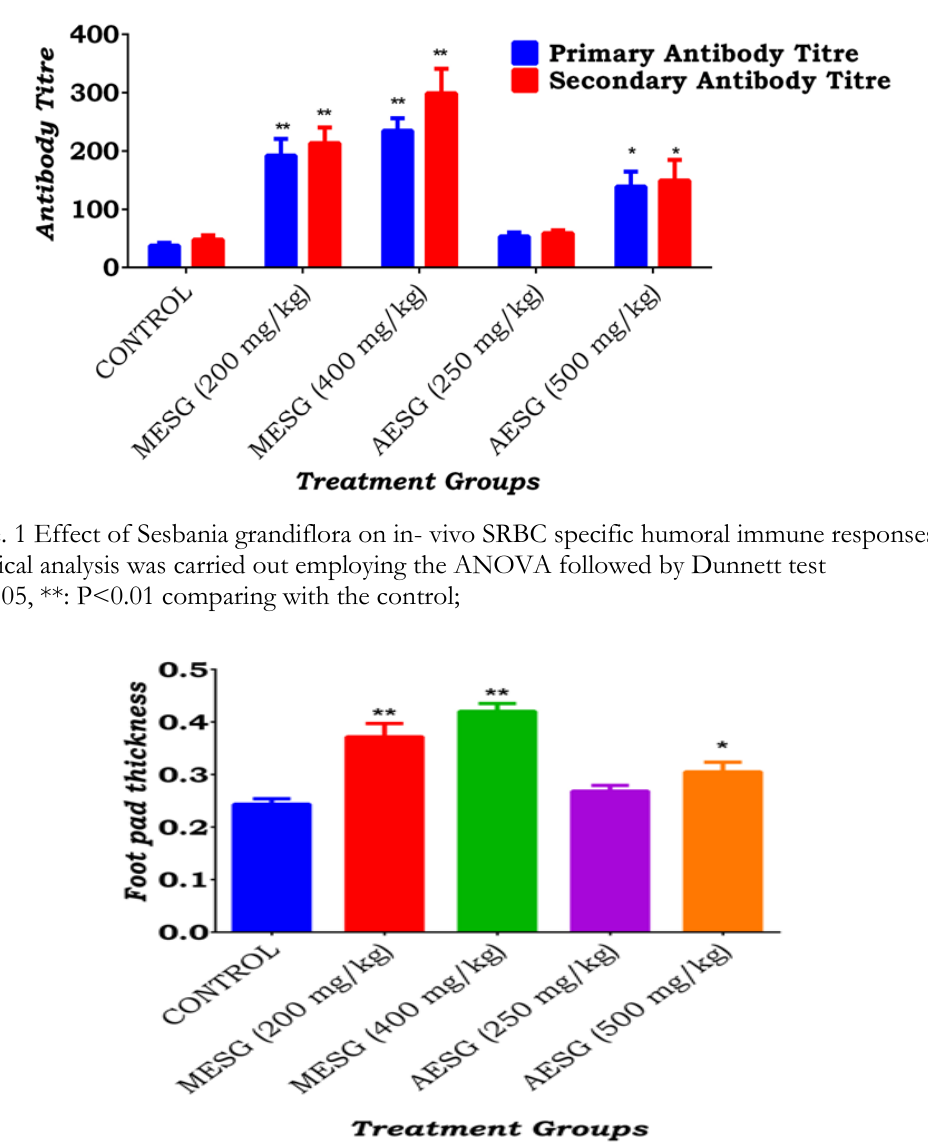
Figure 2. Effect of Sesbania grandiflora on in-vivo SRBC –induced delayed type hypersensitivity reaction. Statistical analysis was carried out employing the ANOVA followed by Dunnett test *: P<0.05, **: P<0.01 comparing with the